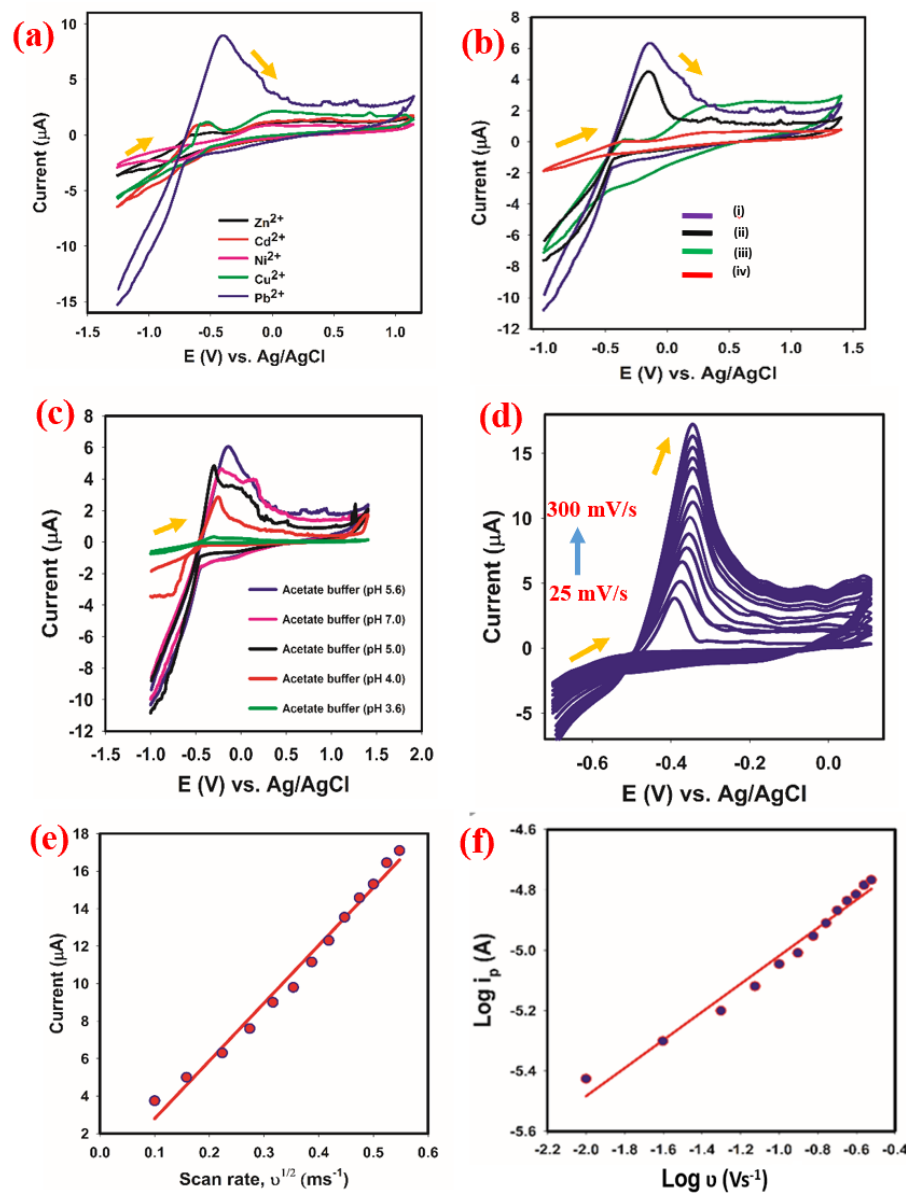
Figure 4. ( a ) The cyclic voltammogram recorded for selectivity study in 1 µM of the analytes. ( b ) The cyclic voltammogram obtained for control study: (i) PANI-GO-APTES_AcB + 0.5 µM Pb 2+ ; (ii) GO-APTES_AcB + 0.5 µM Pb 2+ ; (iii) PANI-GO-APTES_AcB only; (iv) bare GCE_AcB only. ( c ) The cyclic voltammogram obtained in acetate buffer containing 0.5 µM Pb 2+ in different pH media. ( d ) The cyclic voltammogram obtained at different scan rates—10 to 300 mV/s. ( e ) Plot of reduction peak current versus square root of the scan rate. ( f ) Plot of log of peak current versus log of scan rate.